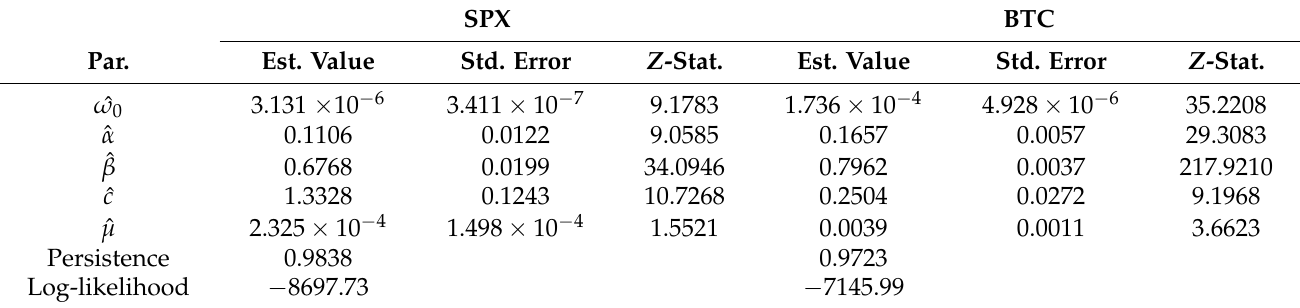
Table 1. Estimated parameters of the NGARCH SV model. SPX